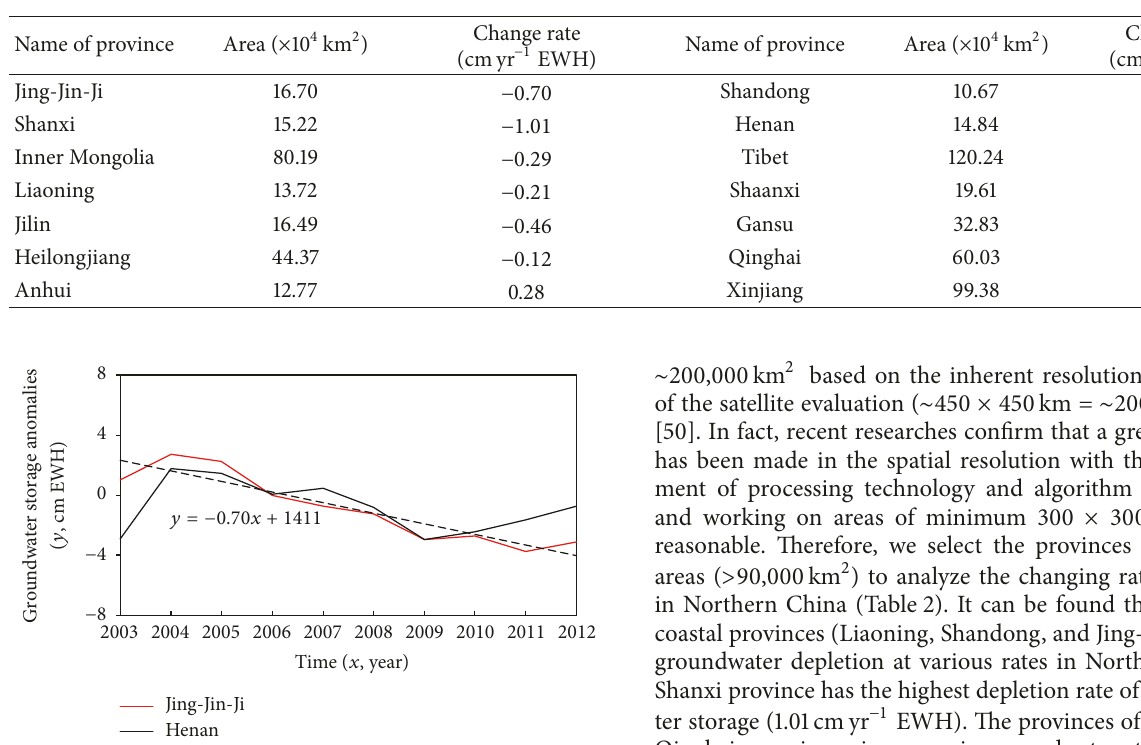
Table 2: Change rates of yearly GWS variations in provinces from 2003 to 2012.